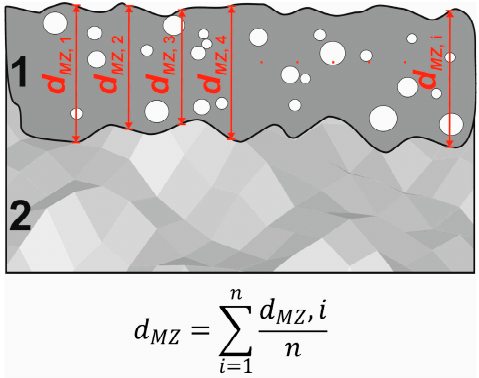
Figure 2. The measurements and calculation of the average thickness of laser-alloyed layer; 1—laser-alloyed layer (re-melted zone); 2—substrate material.